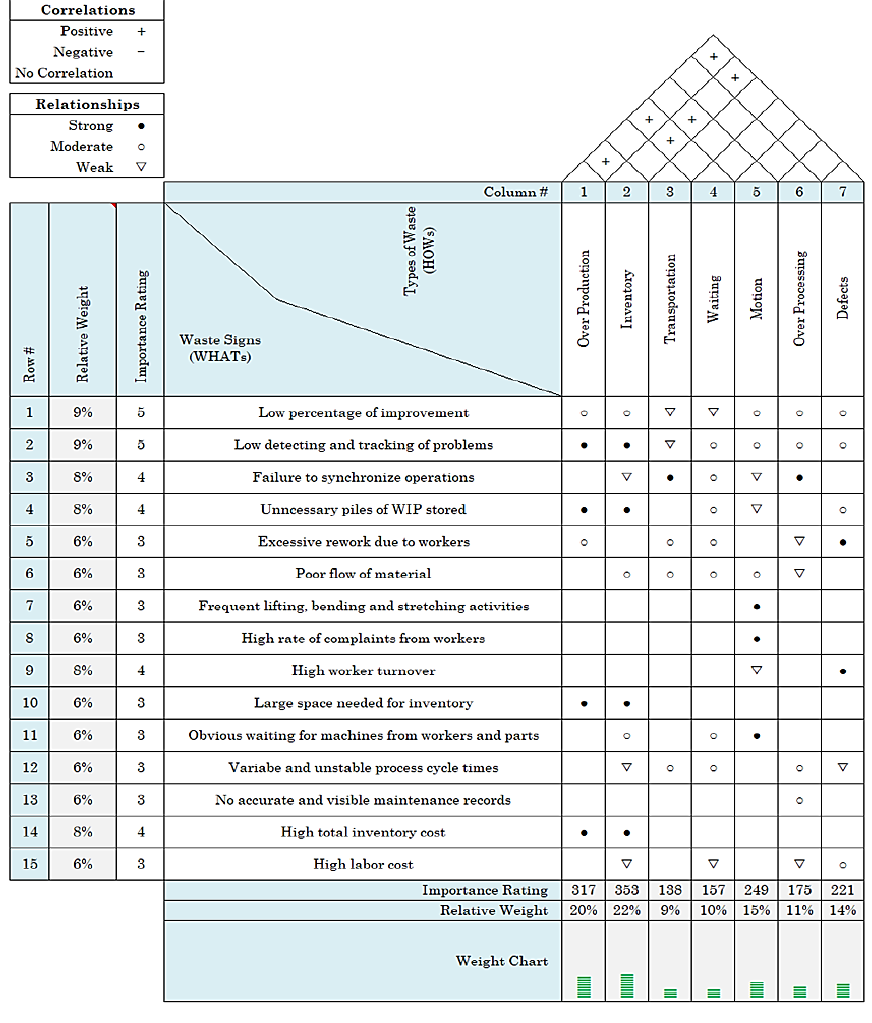
Figure 3. HOQ model developed for this